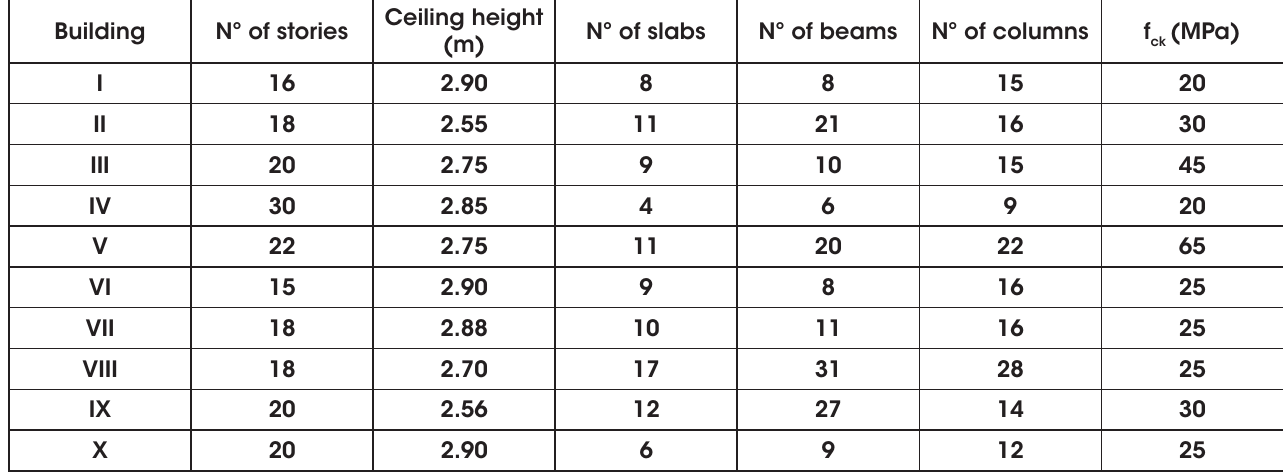
Main characteristics of analyzed